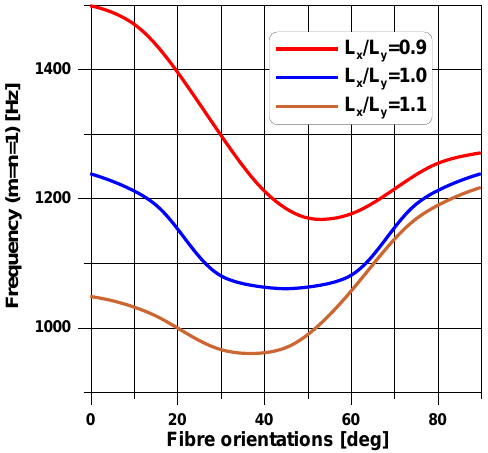
0 Figure 7. Distributions of eigenfrequencies for angle-ply clamped (CCCC) plates. Figure 7. Distributions of eigenfrequencies for angle-ply clamped (CCCC)